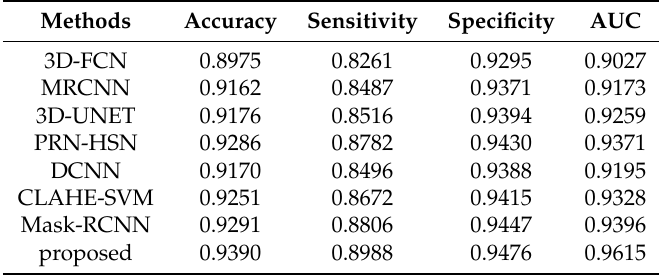
Figure 22. The Precision-Recall curves of applying different methods to detect nodules in the testing dataset of TianChi dataset. Table 9. Quantitative results associated with different nodule detection methods on LUNA16